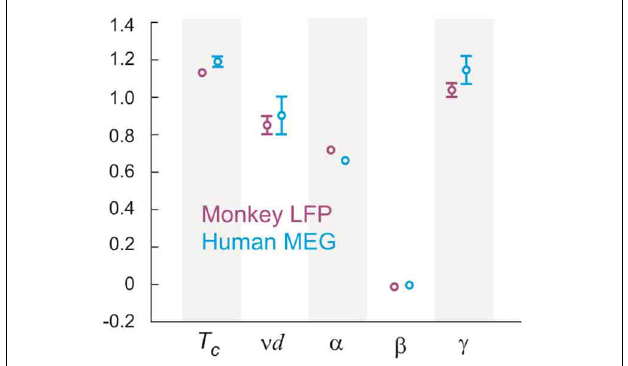
FIGURE 7 | T c and critical exponents α , β , γ , and ν estimated using finite size scaling analysis in two monkeys and three human subjects. Four (two) different 20-electrode/sensor sub-groups were analyzed for each monkey (human) dataset resulting in the sample size of 8 (6). Values are mean (center circle) ± s.d. (error bars omitted for s.d. smaller than center